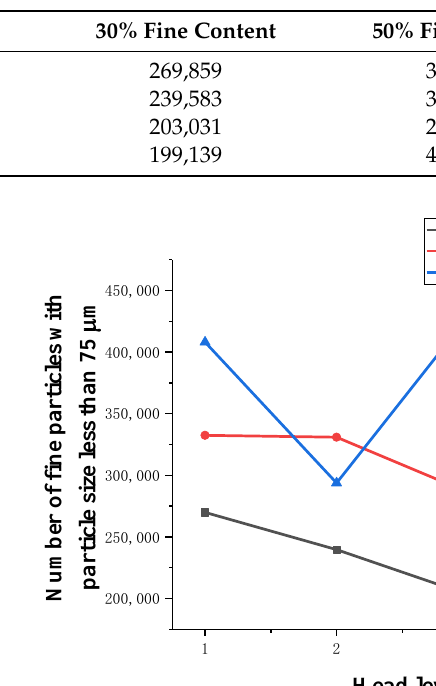
Table 23. Fine particle content change during seepage (0 – 75 µm).